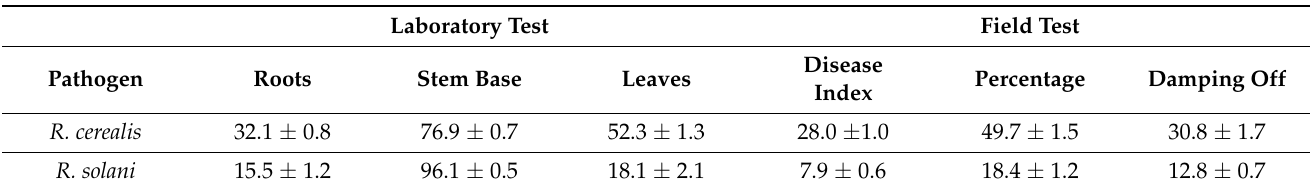
Table 1. Average values for tested parameters ( ± standard deviation) for each pathogen.